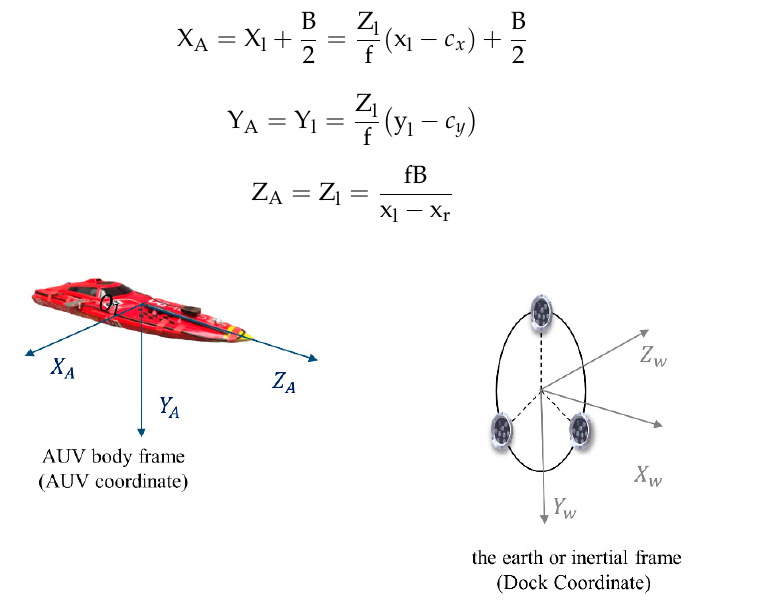
Figure 11. The coordinate frames of the vision guidance system.